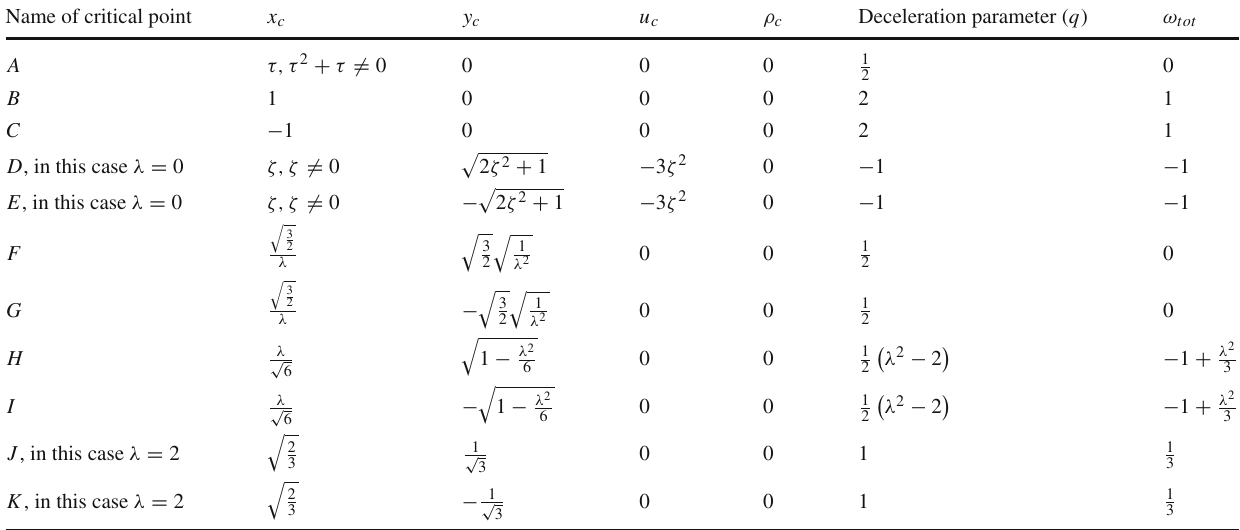
Table 3 Critical points for dynamical system corresponding to Model-I, α = 1 Name of critical point x c y